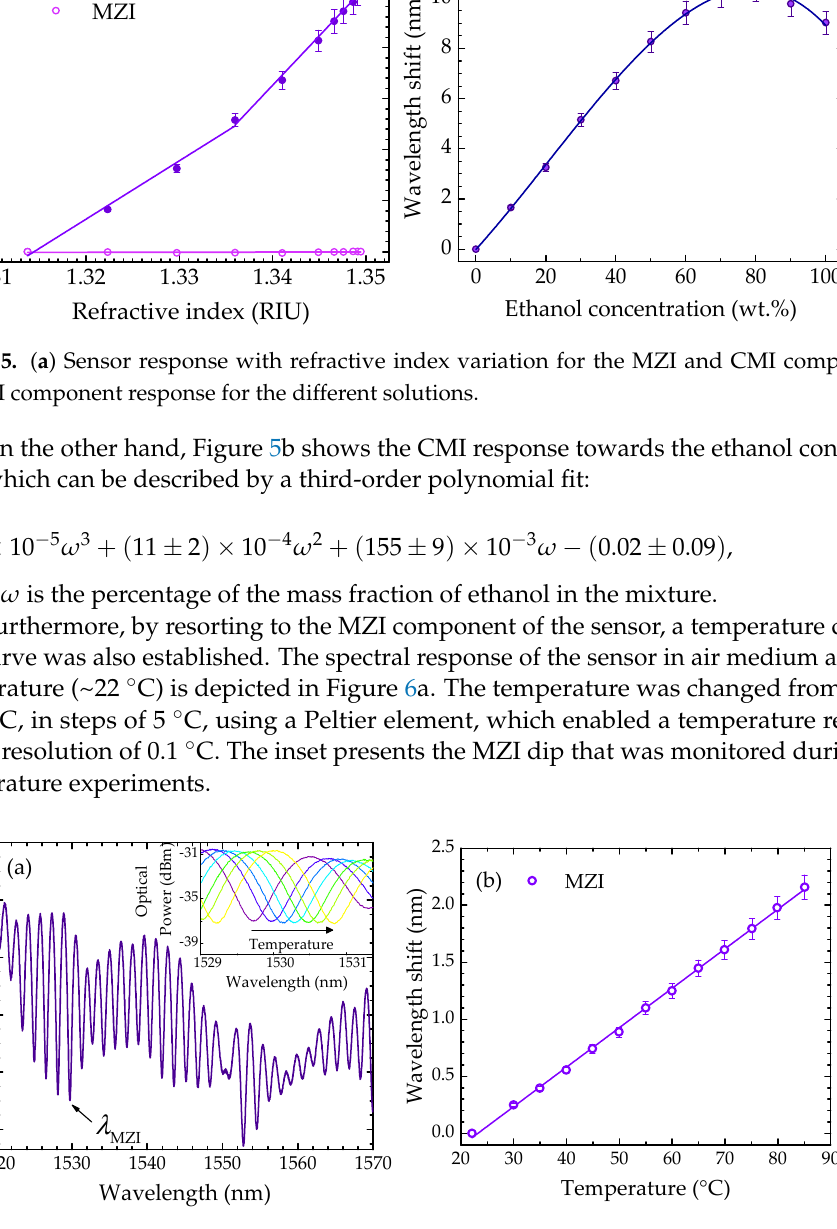
Figure 6. ( a ) Spectral response of the sensor in air medium at 22 ° C, where the monitored MZI dip is shown. In the inset is presented the MZI dip at different temperatures (from 22 ° C to 55 ° C). ( b ) MZI wavelength shift dependence on temperature.